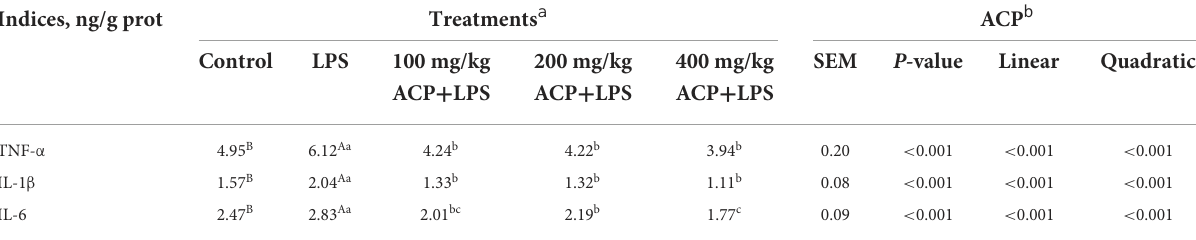
TABLE 5 Effects of Antrodia cinnamomea polysaccharide on liver cytokines of slow-growing broiler breeds challenged with LPS. Indices, ng/g